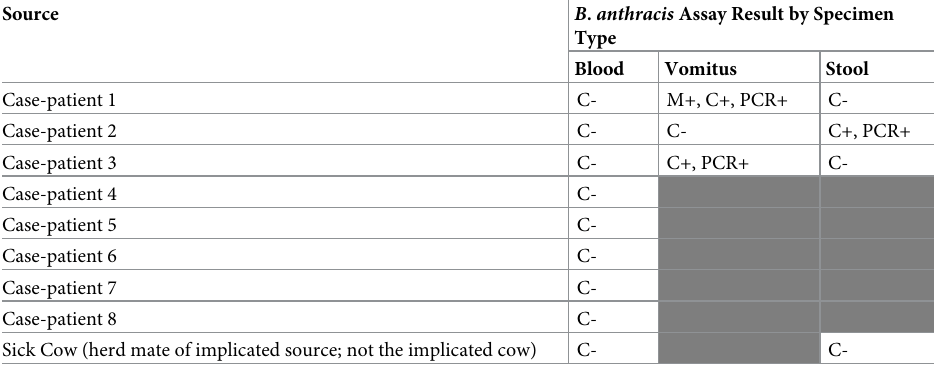
Table 4. Laboratory results of specimen testing during gastrointestinal anthrax outbreak: Isingiro, Uganda, August